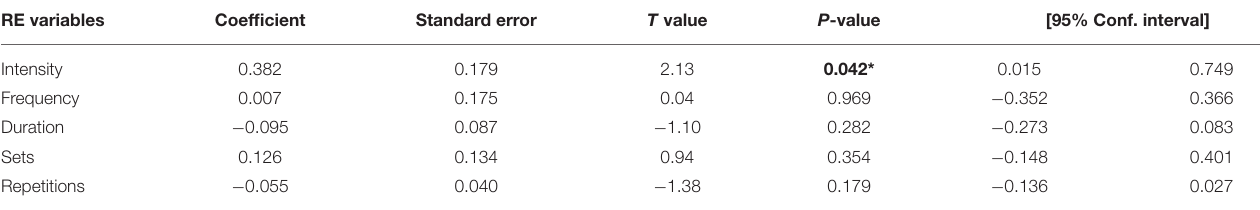
TABLE 2 | Meta-regression analysis for the changes in pulse wave velocity (PWV, m/s) and resistance exercise (RE)